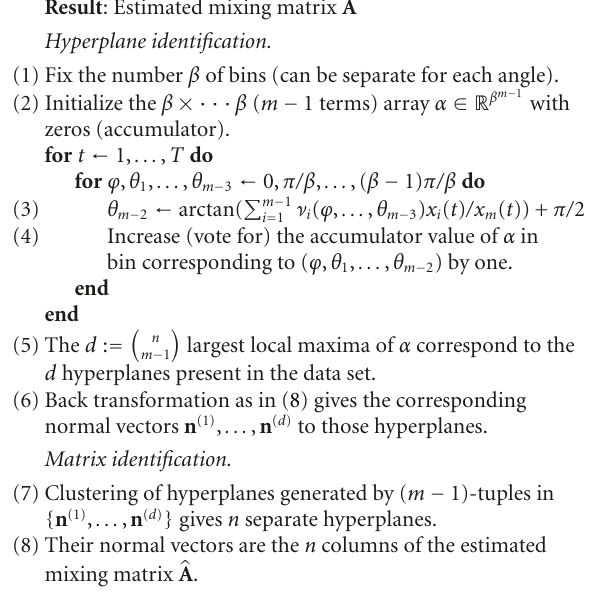
Algorithm 4: Hough SCA algorithm for mixing matrix identifica-